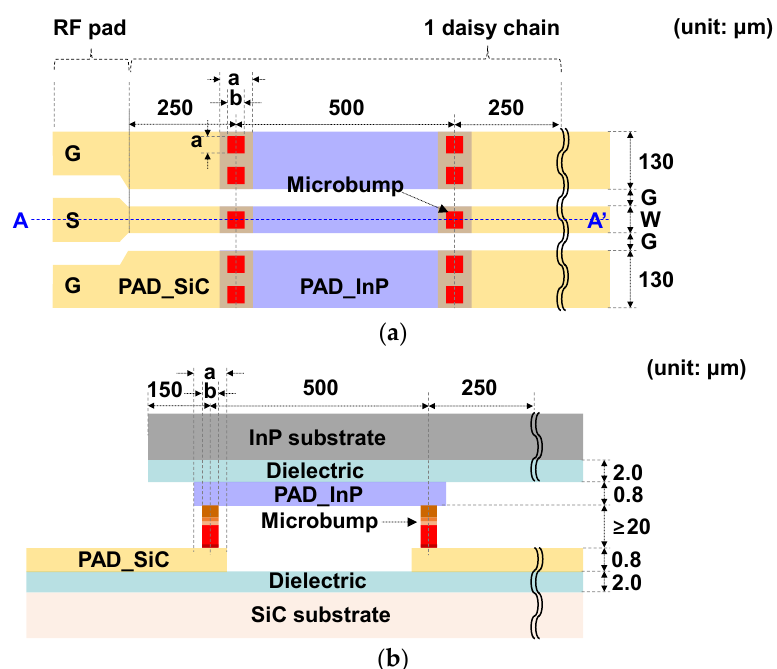
Figure 1. The structure of flip-chip microbump bonding technology for coplanar waveguide (CPW) interconnection between InP and SiC substrates: ( a ) a floor plan; ( b ) a cross-sectional view at point A–A’ in Figure 1a.